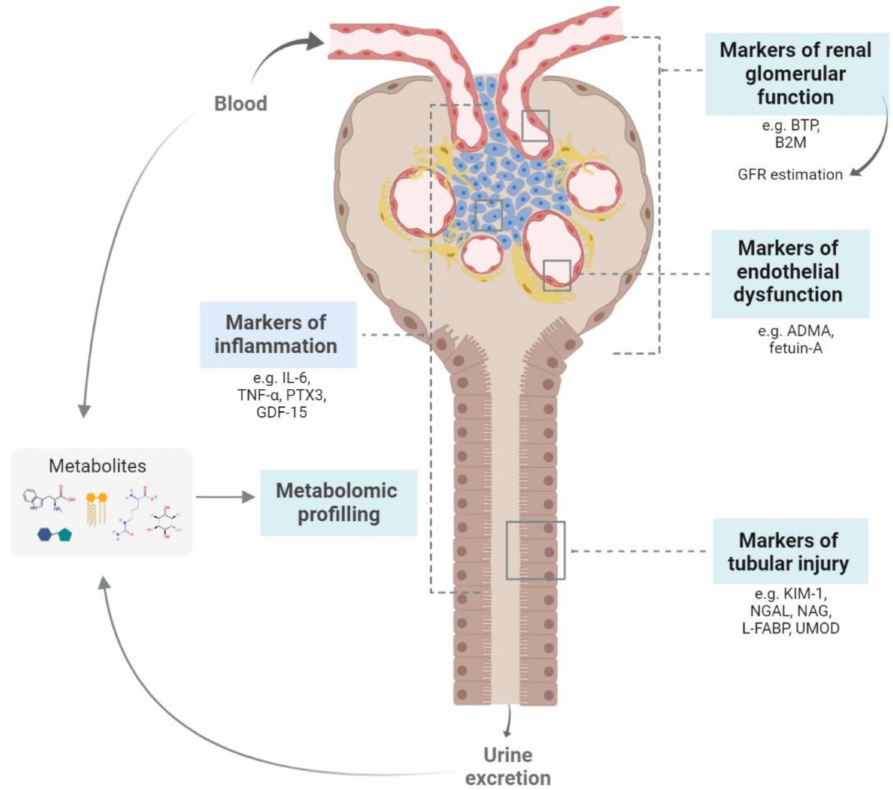
Figure 2. Biomarkers of chronic kidney disease according to the anatomic localization and/or site of